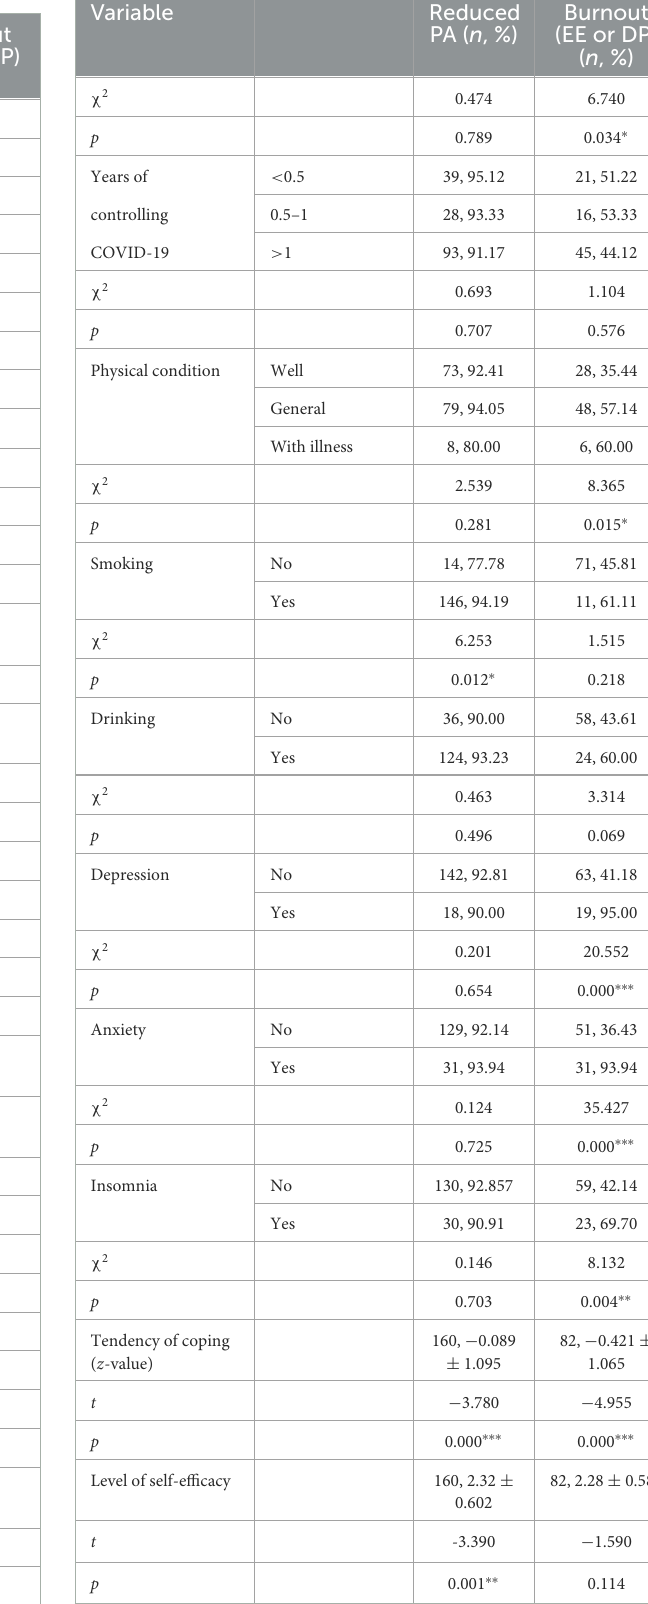
TABLE 2 Comparison in the associated factors of burnout and reduced PA ( N =